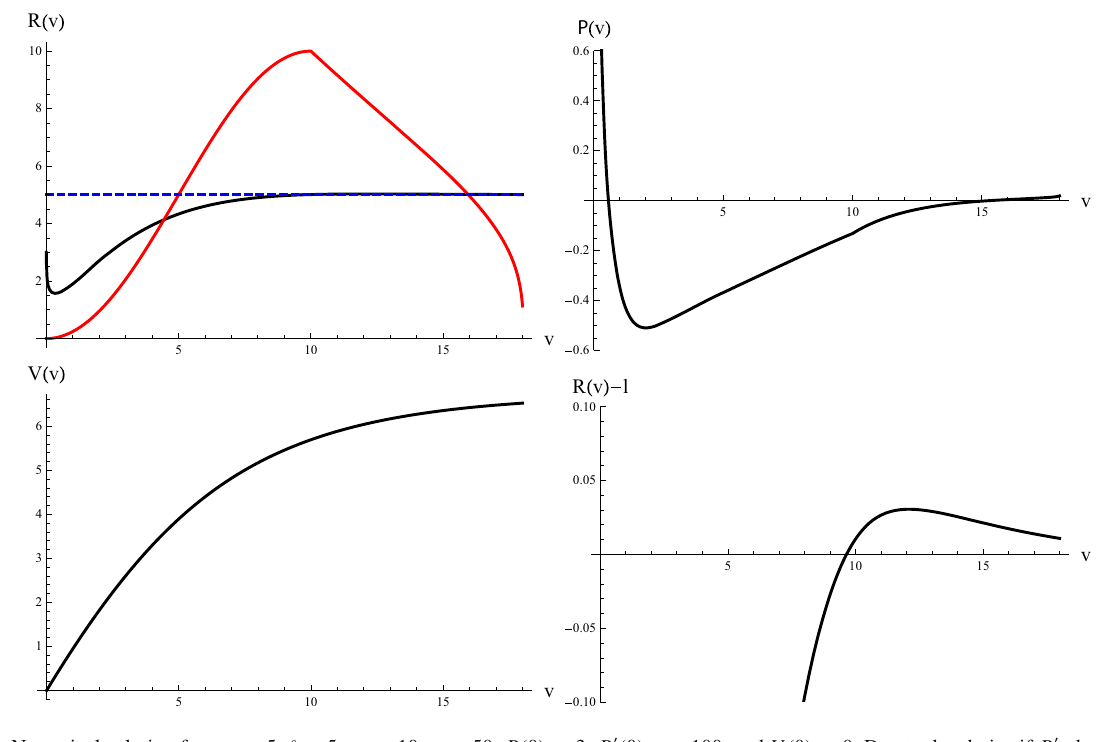
Fig. 2 Numerical solution for m 0 = 5, (cid:3) = 5, v 0 = 10, α = 50, R ( 0 ) = 3, R (cid:2) ( 0 ) = − 100, and V ( 0 ) = 0. Due to the choice if R (cid:2) , the shell can cross r = (cid:3) surface. In this case, there appear outer and inner apparent horizons